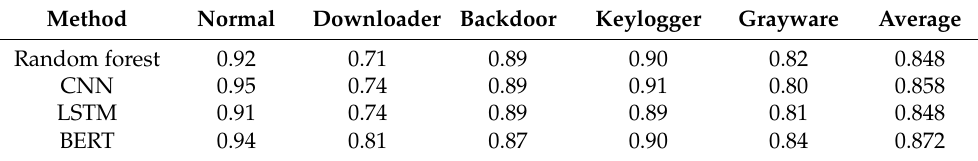
Table 2. Classification effect of the unobfuscated